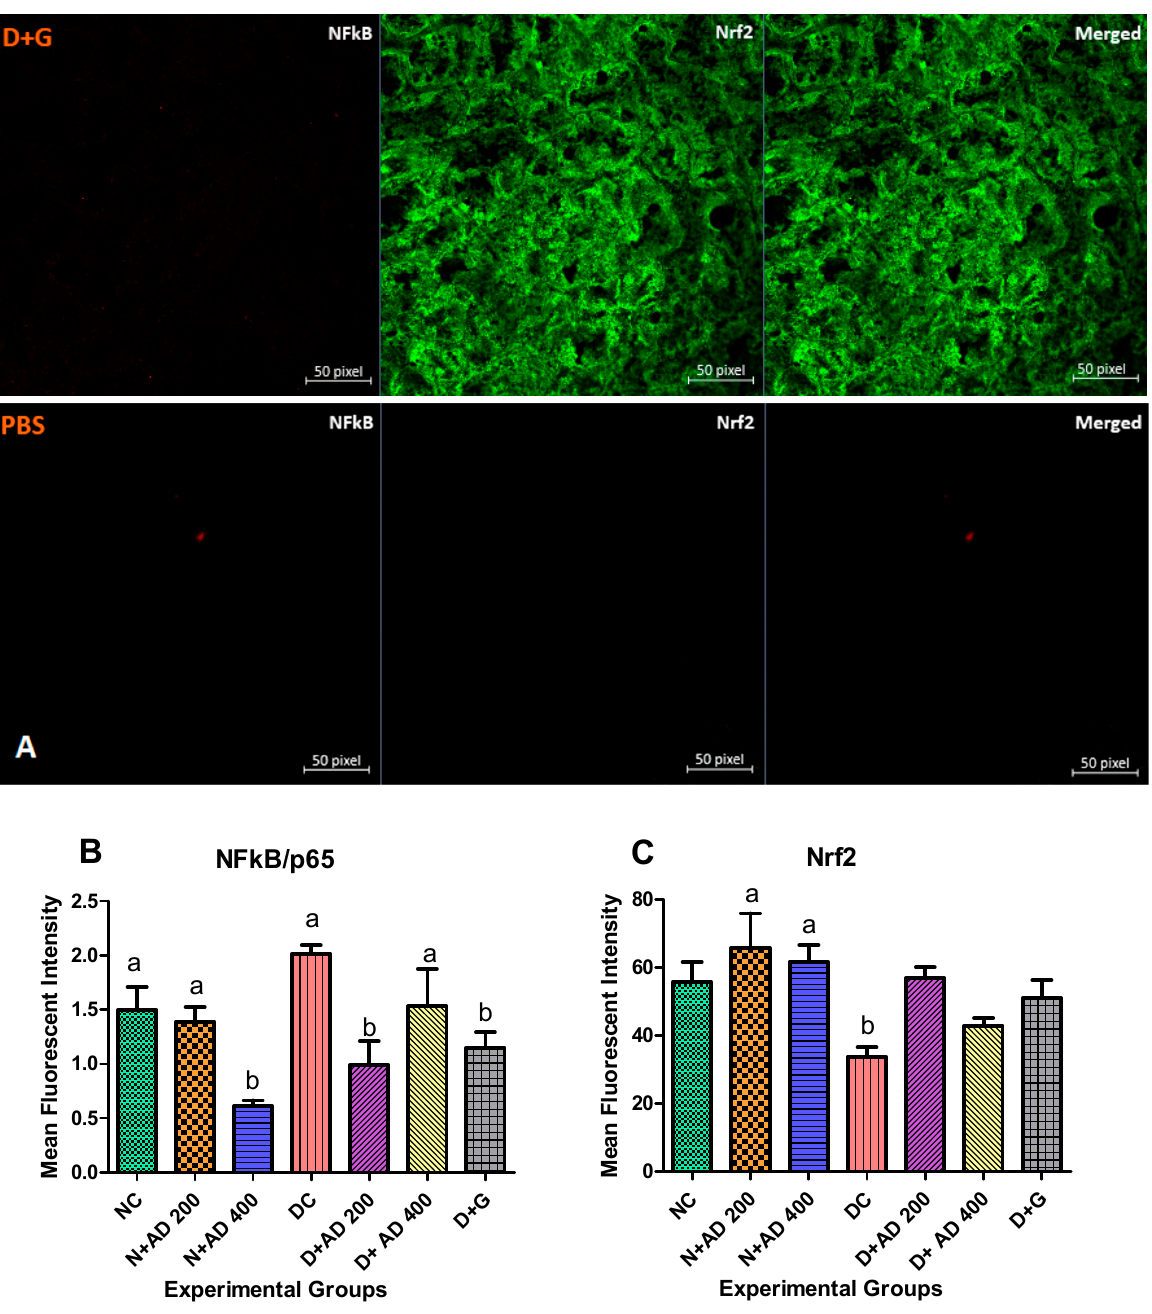
Figure 6. ( A ) Confocal microscopy image showing the effect of AD on the expression of NF-kB/p65 (red) and Nrf2 (green) in the kidney tissues. Quantitative analysis of ( B ) NF-kB/p65 and ( C ) Nrf2 expression in the Kidney tissues. Bars are indicative of mean values ± SEM of group values. Bars with different letters are significantly ( p < 0.05) different from each other.